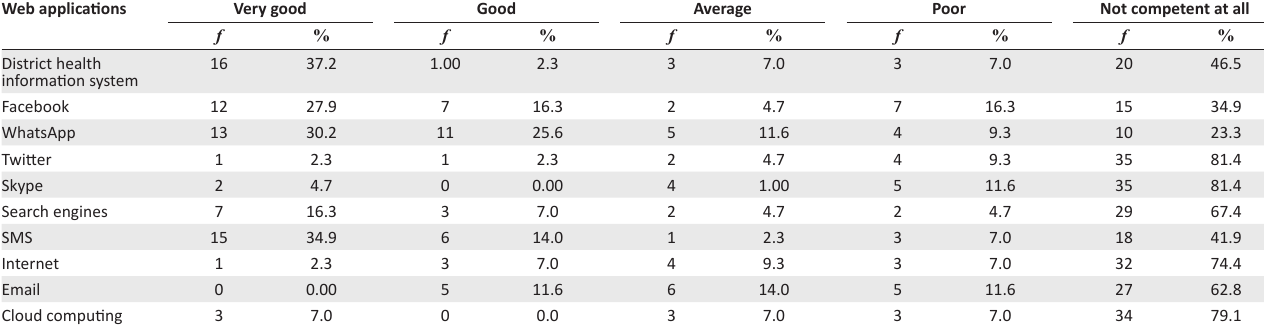
TABLE 2: Competence of health surveillance assistants in using web applications ( n = 43). Web applications